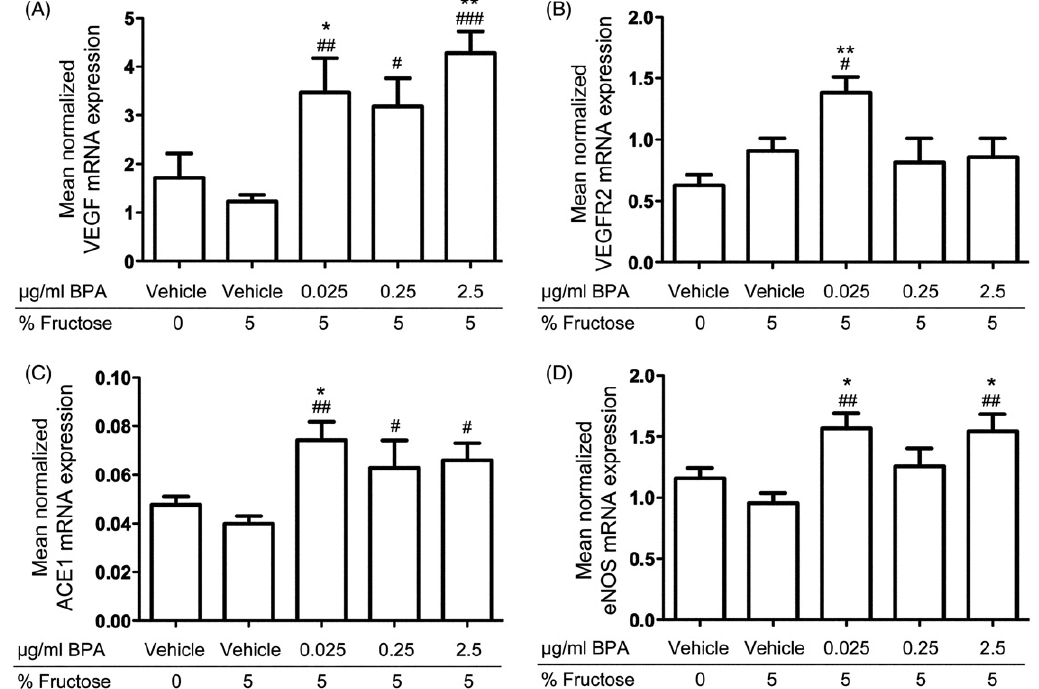
Figure 1. In vivo effects of long-term BPA exposure on VEGF , ACE , eNOS , and VEGFR2 mRNA expressions in rat cardiac tissue. A: Rats exposed to 0.025 l g/mL, 0.25 l g/mL, and 2.5 l g/mL BPA showed increased mRNA expression of VEGF compared to fructose controls and water controls. B: VEGFR2 mRNA expression was increased in rats exposed to 0.025 l g/mL BPA compared to fructose controls and water controls. C: ACE1 mRNA expression was increased in rats exposed to 0.025 l g/mL, 0.25 l g/mL, and 2.5 l g/mL compared to fructose controls and in rats exposed to 0.025 l g/mL BPA compared to water controls. D: Rats exposed to 0.025 l g/mL and 2.5 l g/mL BPA showed increased eNOS mRNA expression compared to fructose controls and water controls. Each bar represents mean normalized mRNA expression±SEM of four animals, each analyzed in three replicates. # P < .05, ## P < .01, ### P < .001, compared to fructose controls. (cid:5)(cid:5)(cid:5) P < .001, compared to water